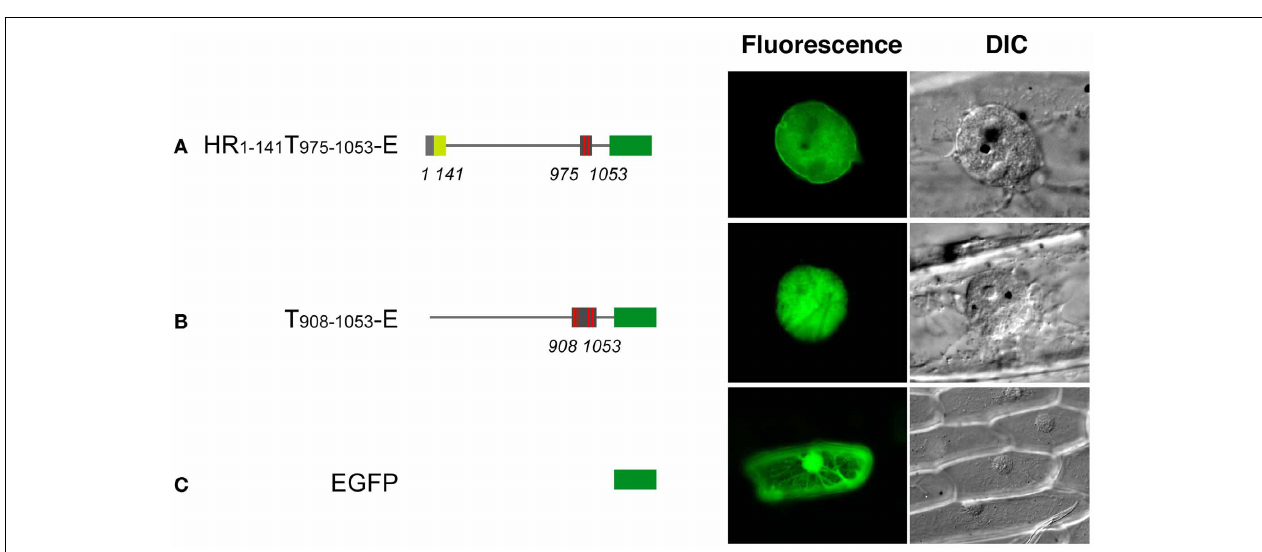
FIGURE 4 | Transiently expressed HR1-141T908–1053-E localizes to the nuclear periphery in Allium cepa epidermal cells. Vectors including genes for HR1-141T908–1053-E (A) , T908–1053-E (B) and EGFP (C) were